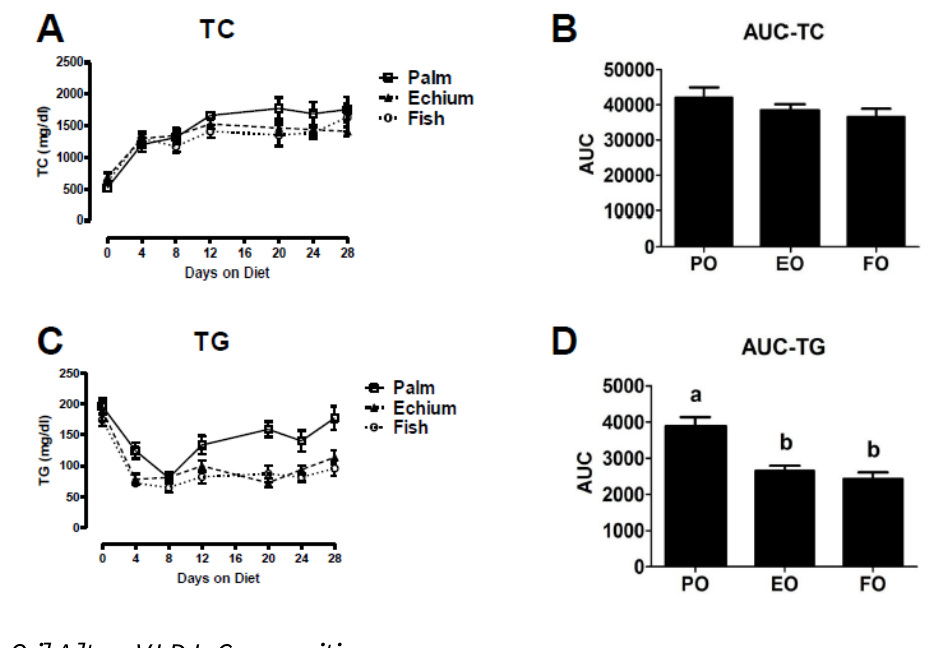
Figure 1. Plasma cholesterol and triglyceride (TG). After a 4 h fast, blood was collected via tail bleeding into 75 µL heparinized capillary tubes. Plasma was isolated from blood by centrifugation at 12,000 rpm at 4 °C. Animals were bled at baseline (0 days), and after 4, 8, 12, 20, 24, and 28 days on diet. Plasma total cholesterol (TC, Wako) and triglyceride (TG, Roche) concentrations were determined by enzymatic assays. Area under the curve (AUC) for each animal was calculated and TC and TG differences among the three diet groups were determined by one-way ANOVA using GraphPad Prism software. TC ( n = palm oil (PO)-6, echium oil (EO)-11, and fish oil (FO)-7) ( A ), area under the curve for TC ( B ), TG ( n = PO-7, EO-12, and FO-8) ( C ) and area under the curve for TG ( D ). Values represent mean ± S.E.M. and different letters represent a significant difference ( p <